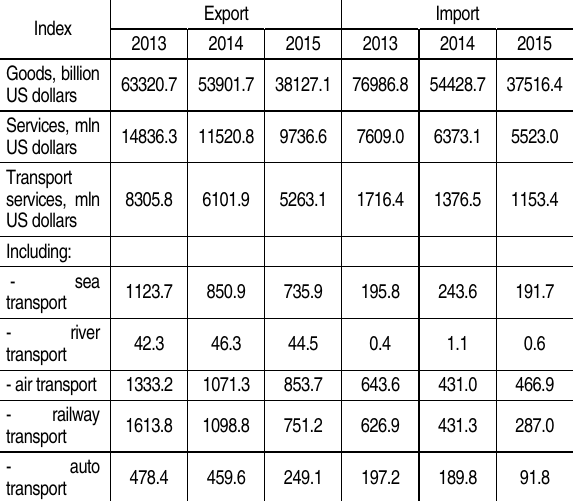
Table 6. Export-import indexes of Ukraine